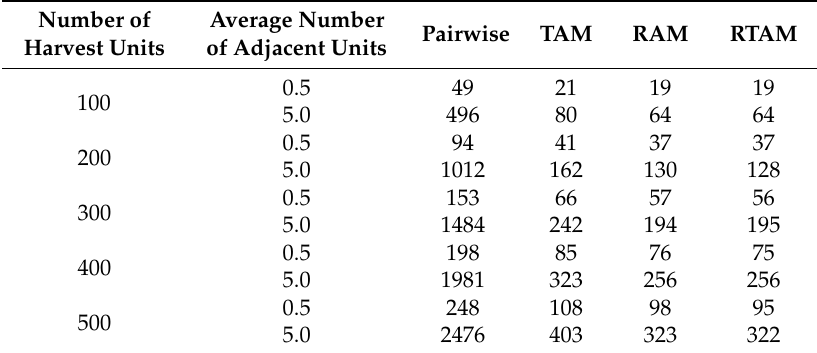
Table 13. Resulting number of adjacency constraints obtained by different algorithms for different types of spatial forest